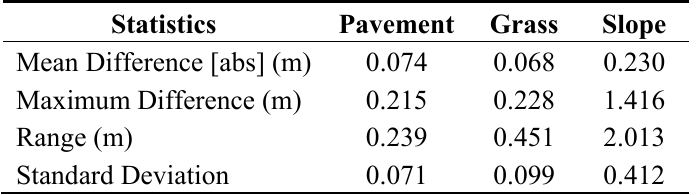
Table 3. Differences between bare-earth airborne and composite LiDAR TIN elevation datasets on various land surface types found by subtracting the composite TIN elevation values from the airborne TIN elevation values.